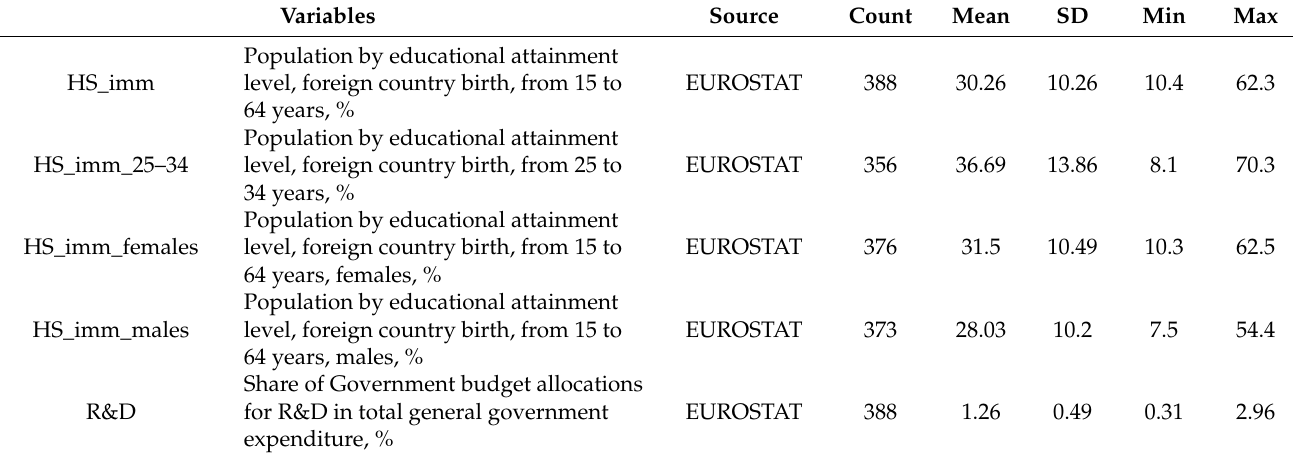
Table A1. Variables used in the analysis,